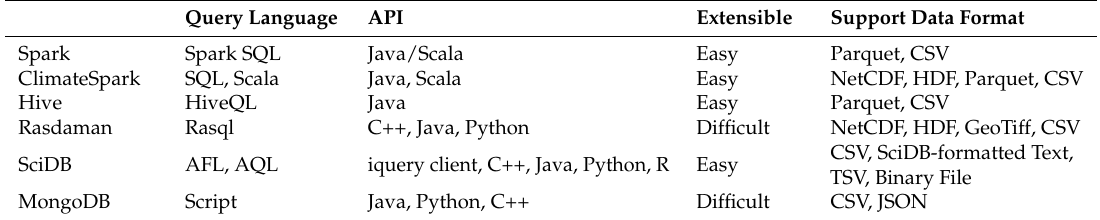
Table 5. The data operation comparison for Spark, ClimateSpark, Hive, Rasdaman, SciDB, and